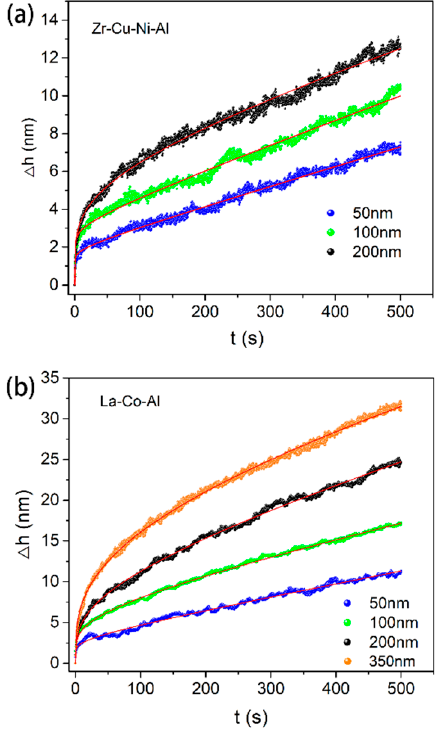
Figure 4. Typical creep displacements versus holding time at various initial holding depths for ( a ) Zr-Cu-Ni-Al and ( b ) La-Co-Al.